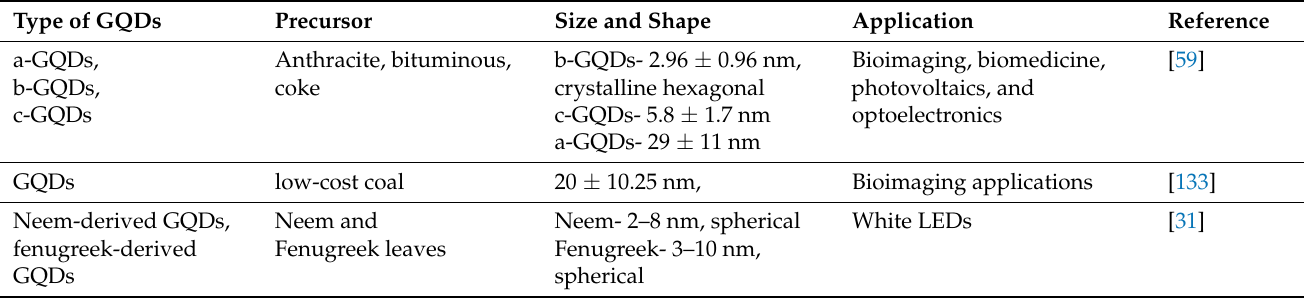
Table 5. The biomass-derived methods for the preparation of